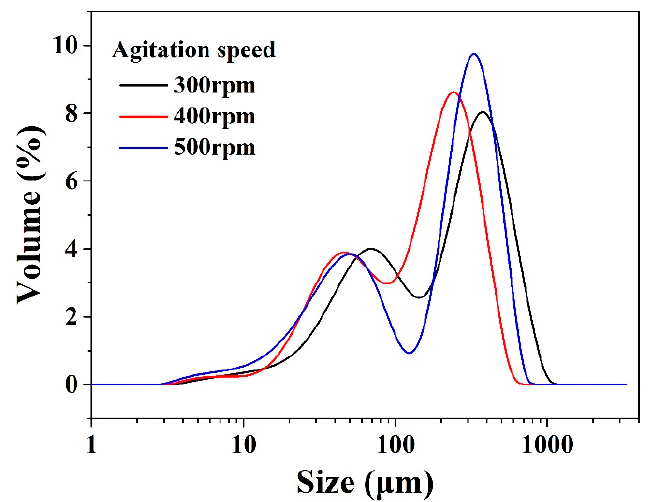
Figure 10. Effect of agitation speed on thermal decomposition crystallization [temperature = 90 °C].